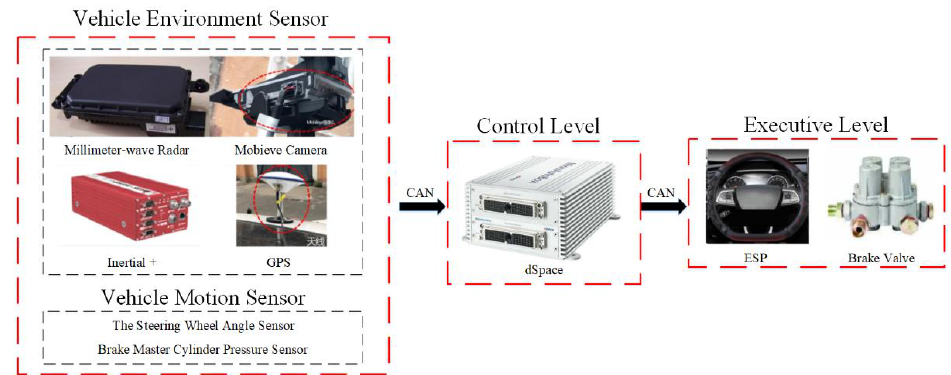
Figure 12. Hardware relationships in the actual vehicle verification process.